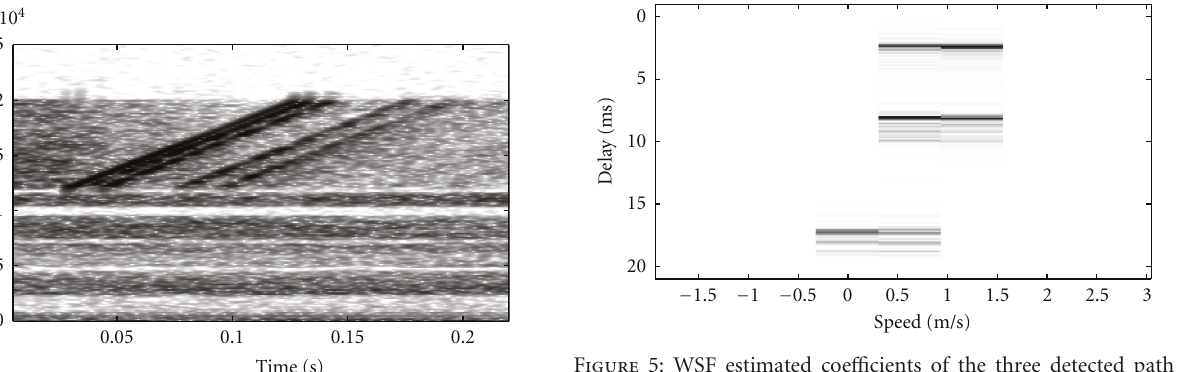
Figure 5: WSF estimated coe ffi cients of the three detected path groups using the WALF method and the received LFM probing signal in the KAM08 experimental data.